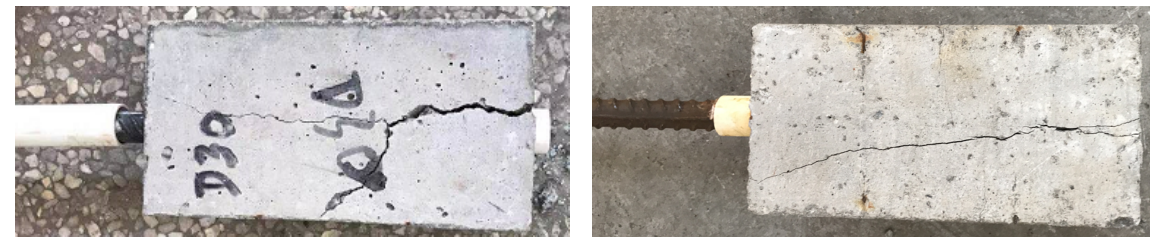
Figure 2: Failure modes of NAC and RAC